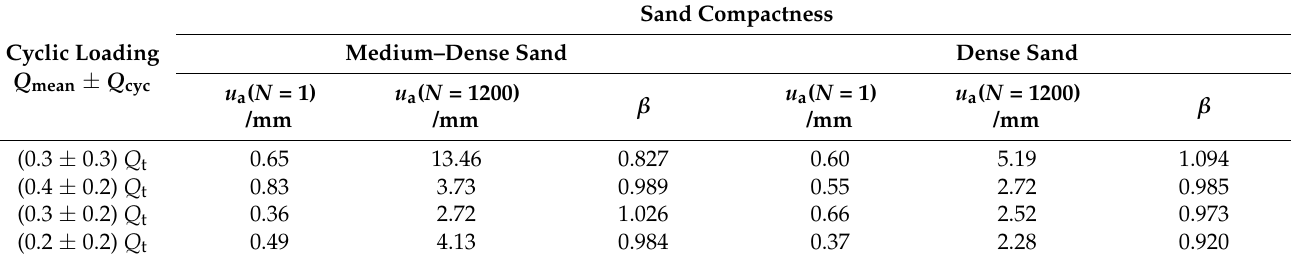
Table 3. Accumulated displacement and post-cyclic uplift capacity ratio for anchors in medium–dense and dense sands.